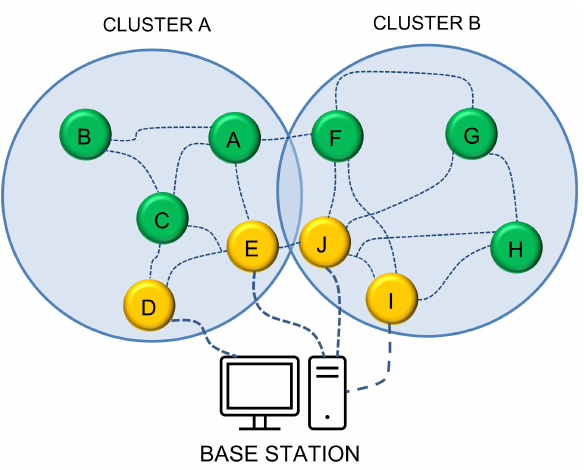
Figure 1. System architecture for region-based energy-efficient multipath